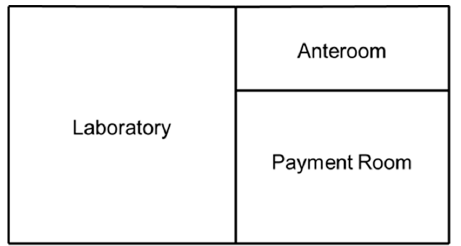
Figure 2. Layout of the